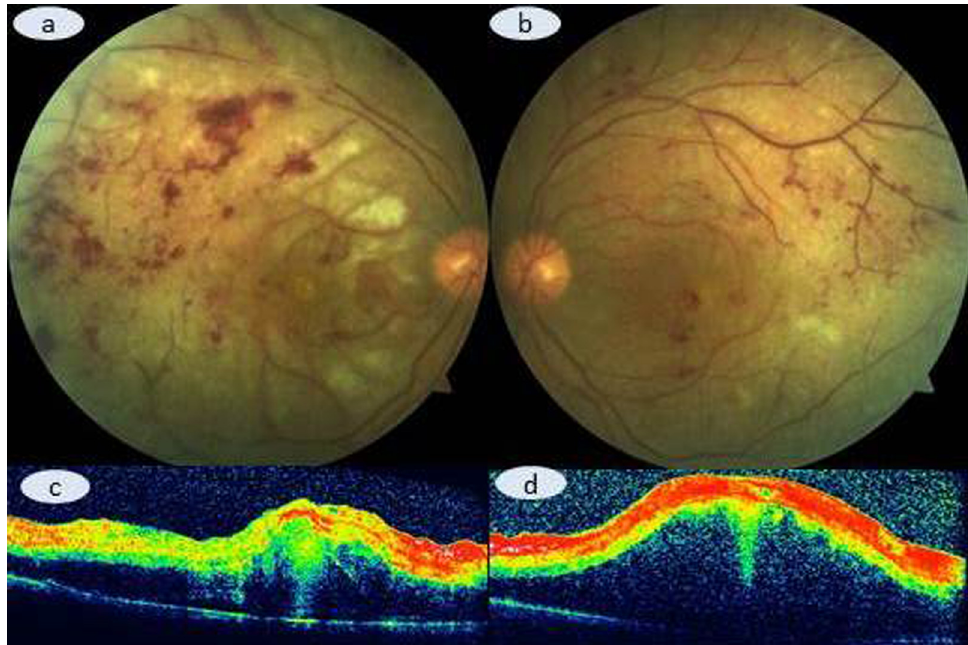
Figure 2: Color fundus picture depicting the slightly increased retinal hemorrhages and continuing retinal whitining (a: right eye; b: left eye). No OCT change is present in the right (c) and left eye